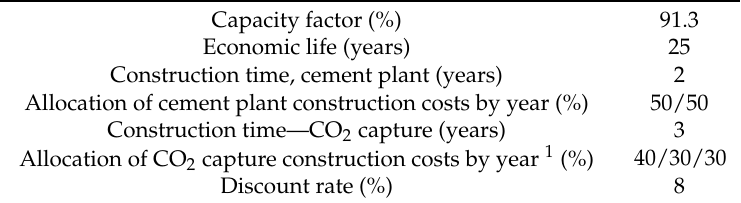
Table 5. Economic boundaries and financial parameters used in calculating economic